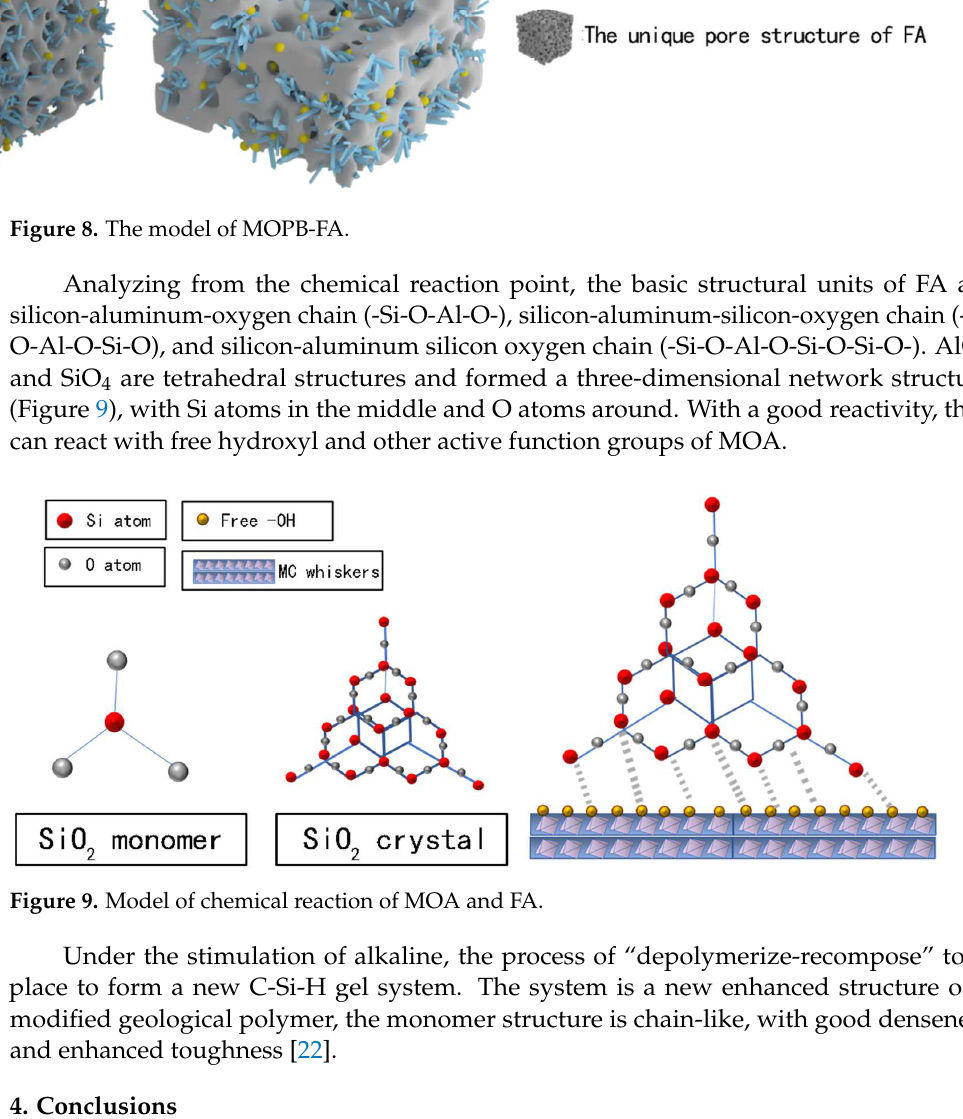
Figure 9. Model of chemical reaction of MOA and FA.